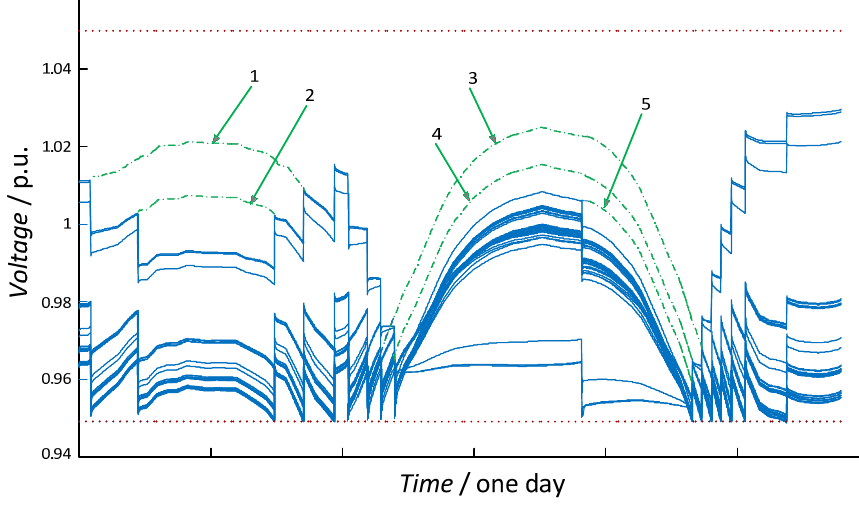
Figure 7. One day voltage profile of MV/LV substations. The green dotted lines marked from 1 to 5 represent a few possible scenarios in which the decision to switch or not must be made. The algorithm generates simulations between two tap positions which have the same